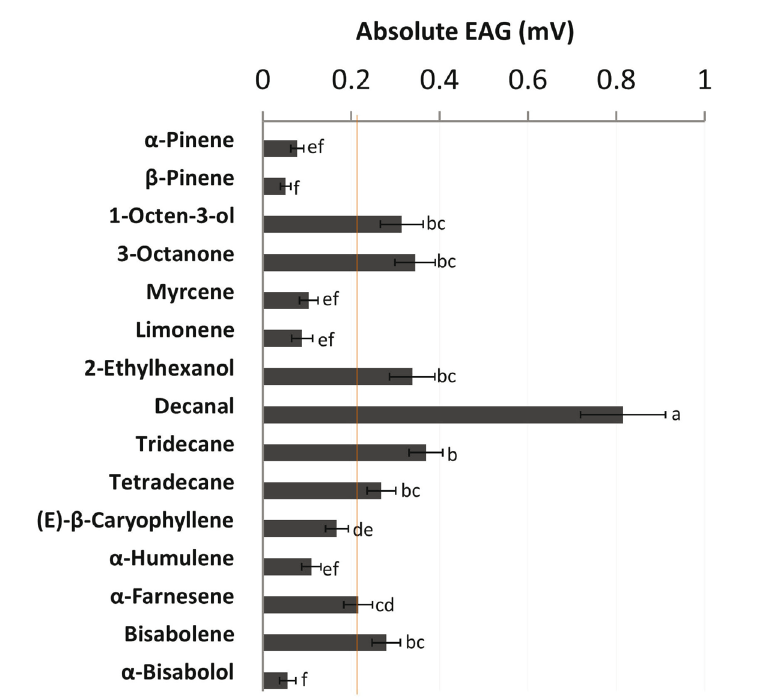
Figure 1. EAG responses of Microplitis croceipes to synthetic compounds. Mean absolute Electroantennogram (EAG) responses (mV ± SEM; N = 15) of female Microplitis croceipes to 15 volatile compounds identified in the headspace of cotton-fed Heliothis virescens larvae 5 . Synthetic compounds were formulated in hexane (solvent control) and tested at an optimum dose of 1 μg. Orange line indicates the arbitrary response threshold of 0.22 mV (50 th percentile rank). Bars with no letters in common are significantly different ( P <0.05; Kruskal-Wallis test followed by Sidak’s multiple comparison